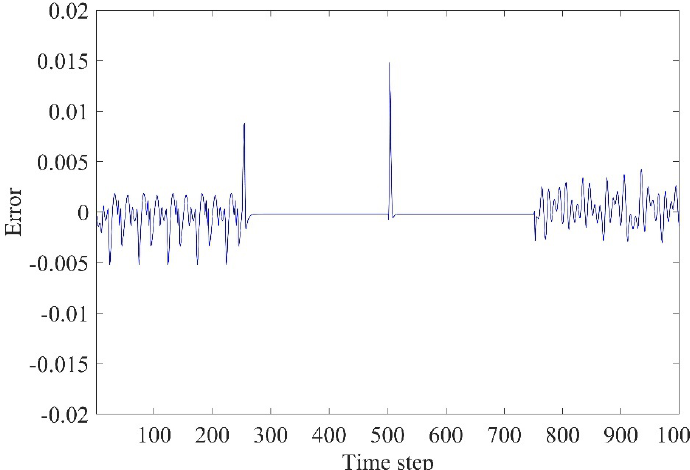
Figure 9. The errors of the system identification of longer input delays between the real output and the output obtained using the STFCMAC model.